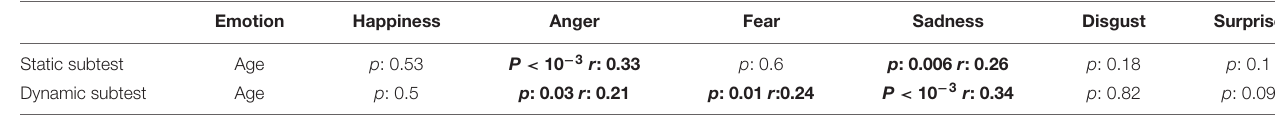
difference ( p = 0.001 for the age group 7–8 years and 11–12 years, p = 0.003 for the age group 9–10